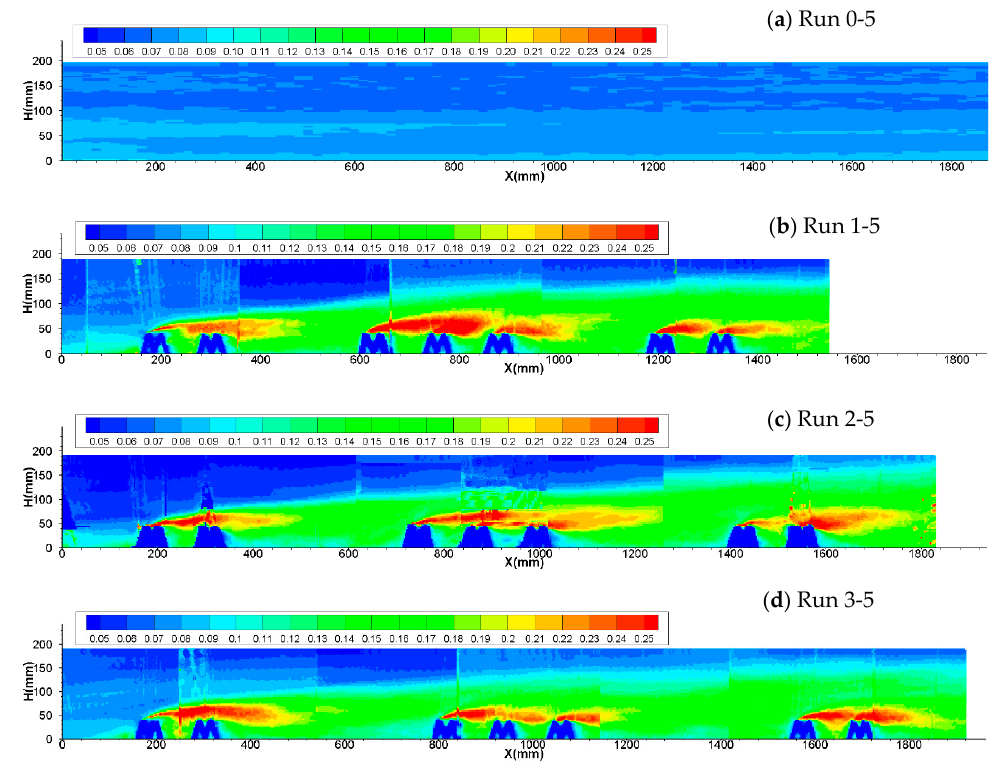
Figure 6. Longitudinal turbulence intensity for cases 0-5, 1-5, 2-5, and 3-5.